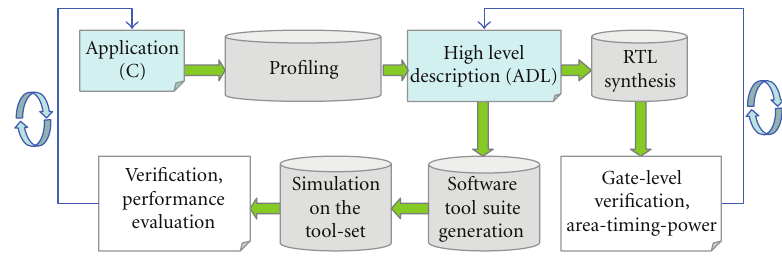
Figure 3: The standard LISA design